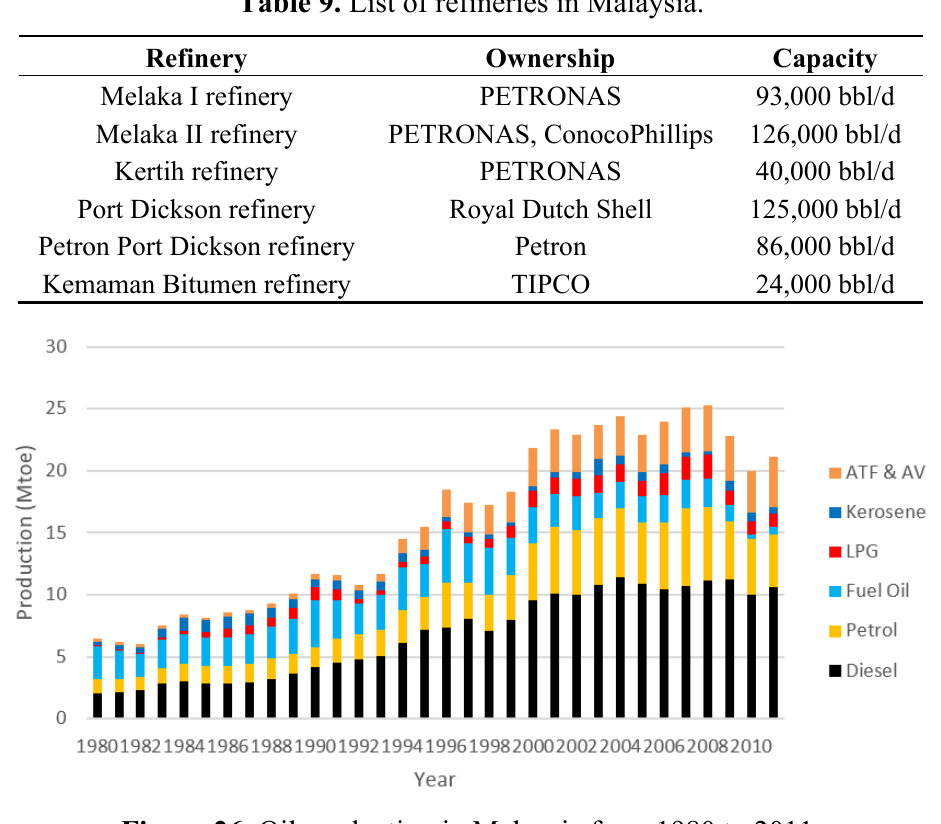
Figure 26. Oil production in Malaysia from 1980 to